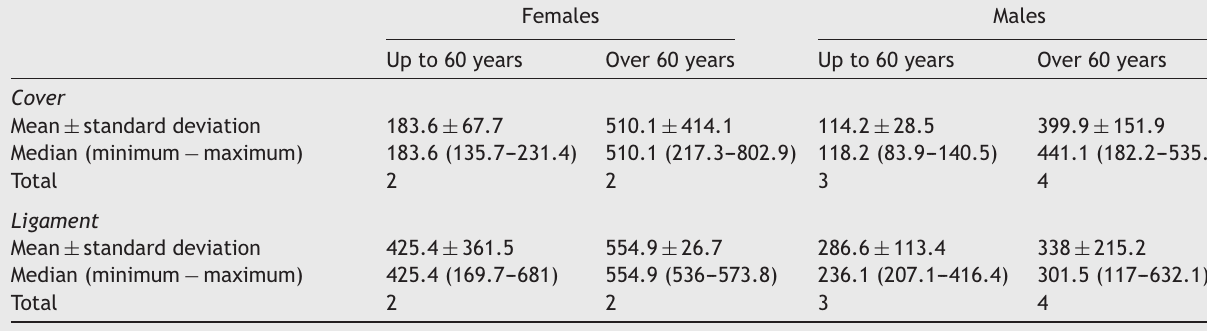
Table 5 GAG concentration according to gender and age range in: cover and ligament.